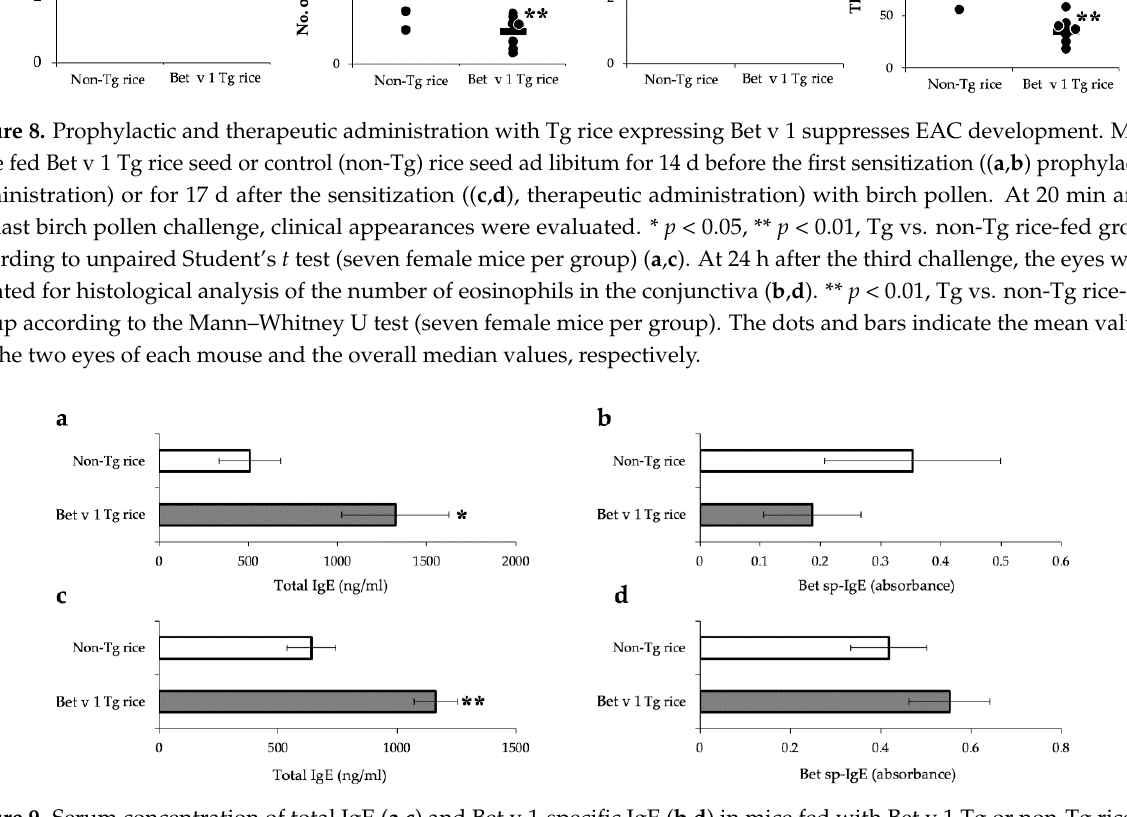
prophylactic ( a , b ) and therapeutic ( c , d ) protocol. Data are presented as ng/mL or absorbance units. * p < 0.05, ** p < 0.01,